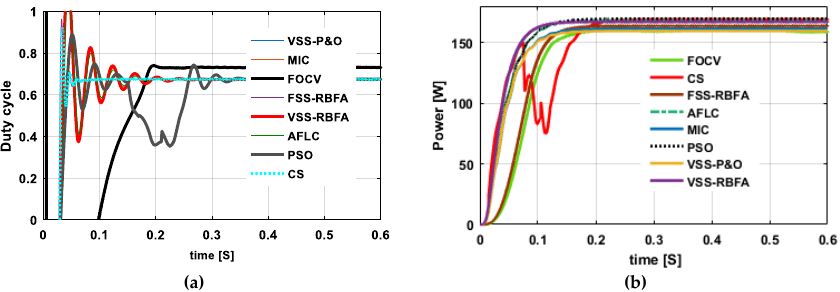
Figure 15. ( a ) Duty cycle and ( b ) output power of a switched capacitor boost converter (SCBC) by applying different MPPT techniques at 800W/m 2 .